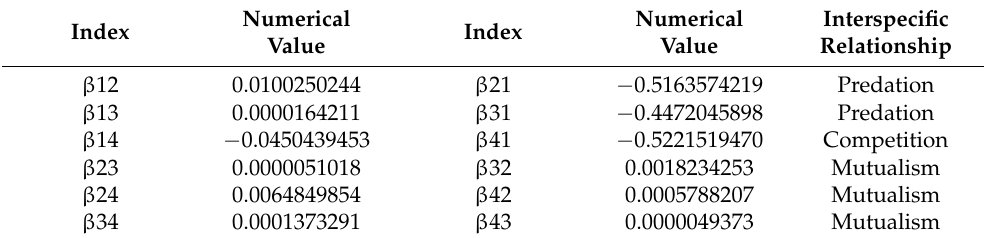
Table 14. The relationship between forecasting data systems in Hebei